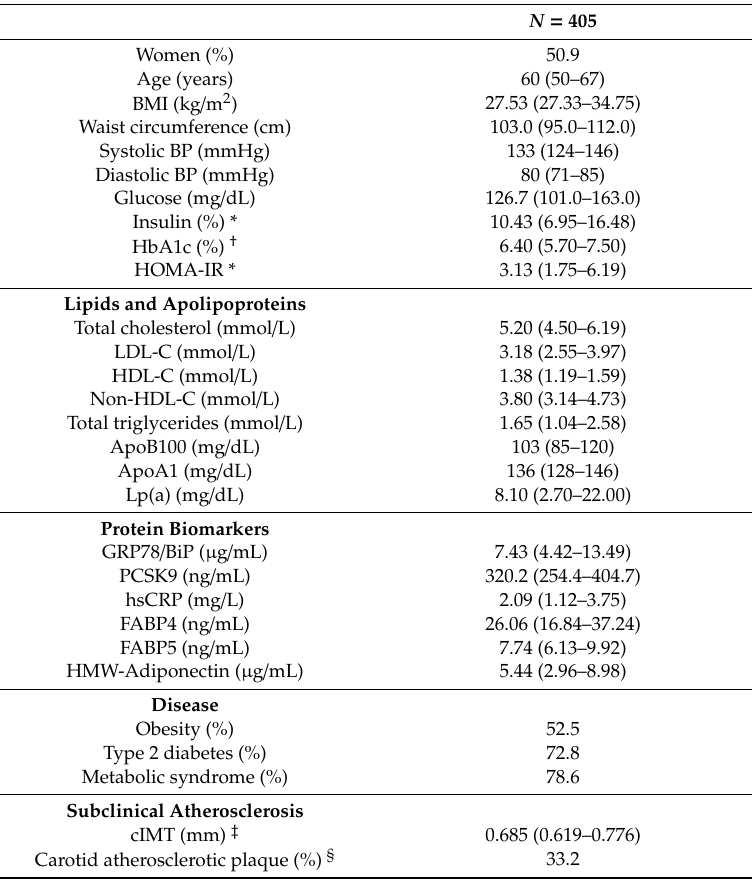
Table 1. Clinical and biochemical characteristics of the study